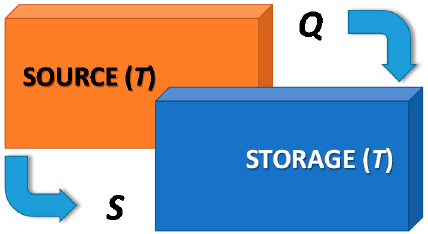
Figure 2. Adsorption of refrigerant over the external surface of an adsorbent solid material.